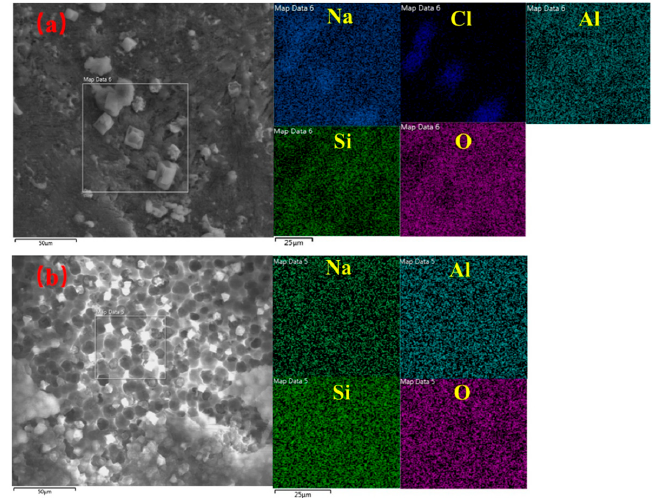
Figure 10. The morphology of slag under SEM and energy spectrum analysis: ( a ) 1400 °C; ( b ) 1450 °C.